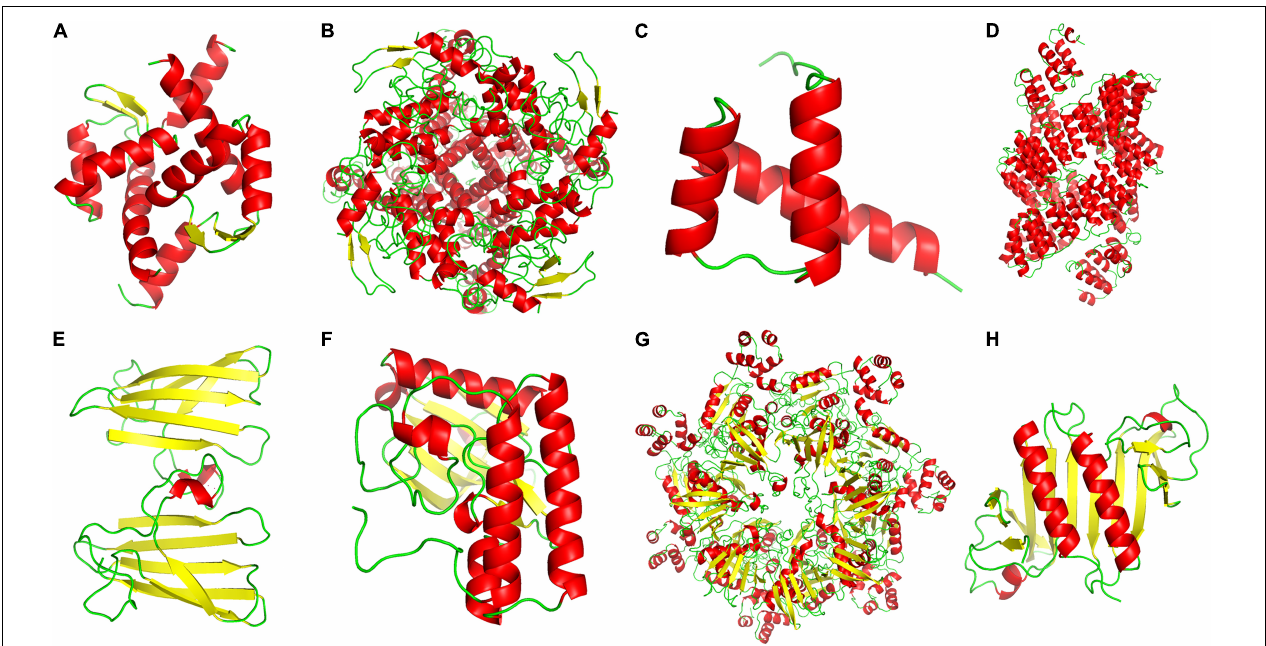
FIGURE 9 | The secondary protein structures of some positively selected genes. (A–C) Positively selected genes (PSGs) related to transmembrane transport, ion homeostasis and water retention. (D) PSGs related to genetic information process. (E,F) PSGs related to the stress response. (G,H) PSGs related to photosynthesis and energy metabolism. Red color represented the α -helix, the yellow color stand for the β -sheet, and the green color stands for the β -turn.